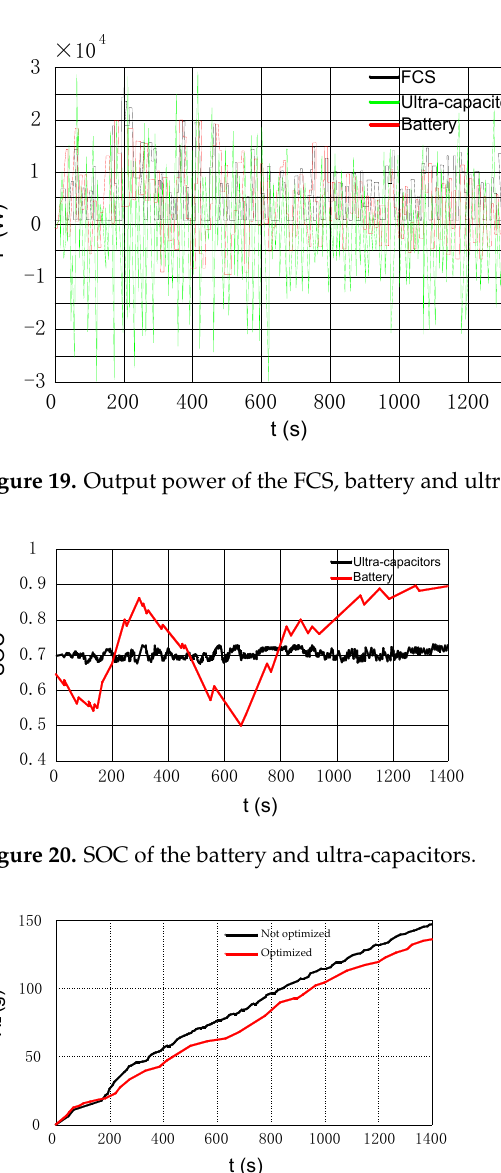
Figure 18. Voltage variations during the UDDS drive cycle.